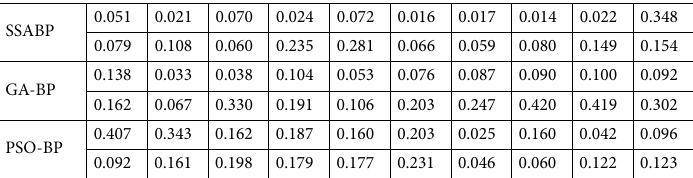
Table 12. Predicted value variance of SSA-BP, GA-BP and PSO-BP at P2.